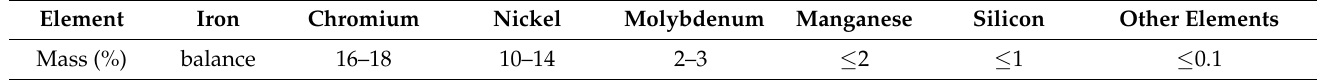
Table 1. Mass composition of elements of austenitic stainless steel alloy (SS 316L-0407). Element Iron Chromium Nickel Molybdenum Manganese Silicon Other Elements Mass (%)